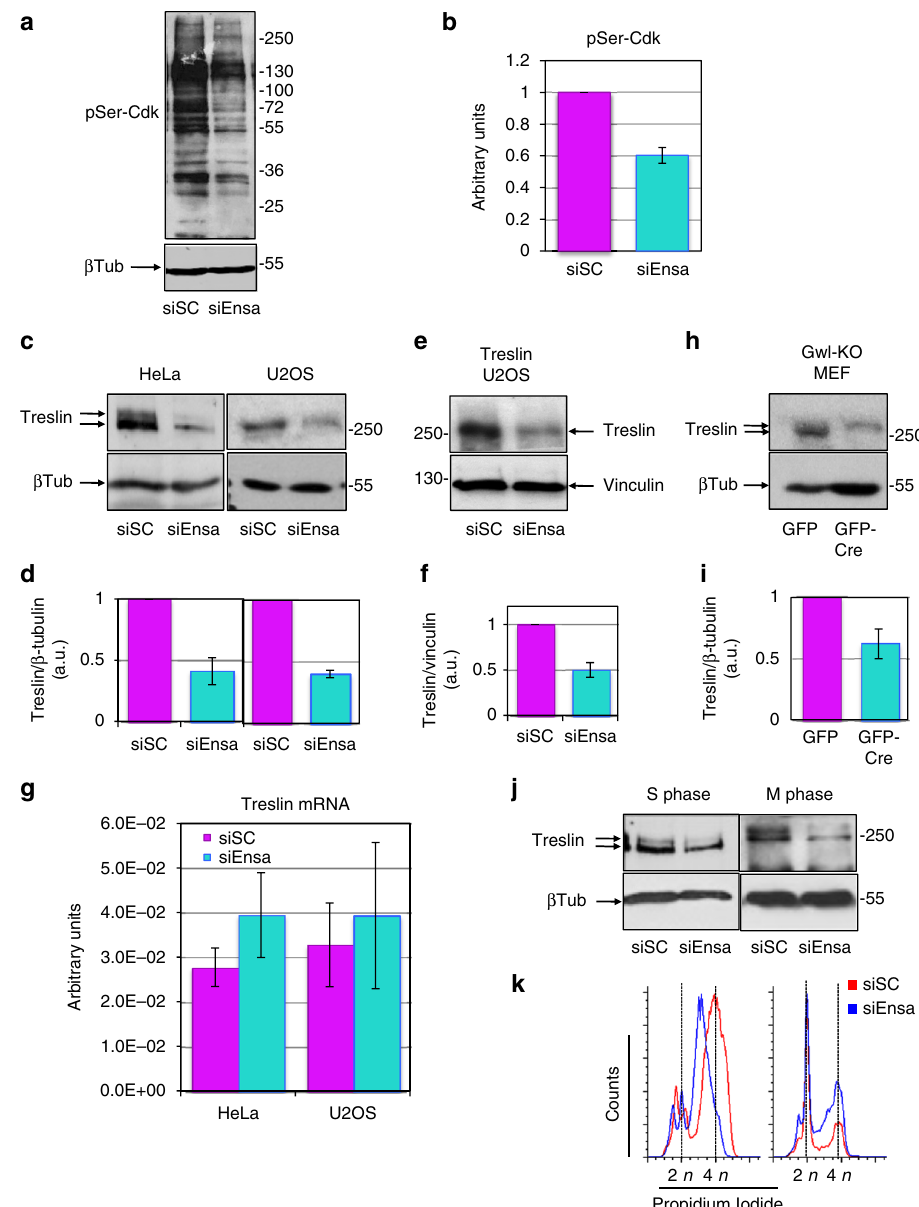
Fig. 7 Depletion of Ensa decreases Treslin protein levels. a Representatitve immunoblotting of phosphorylated Cdk substrates in control (siSC) and Ensa siRNA-treated cells (siEnsa). b Phospho-Ser Cdk intensities on the western blot were measured by densitometry using ImageJ software in fi ve independent experiments. Mean intensity was normalised to controls and represented as bars and standard deviation . c Immunoblotting of Treslin and, as loading controls, β -tubulin in HeLa and U2OS cells treated with scramble (siSC) or Ensa siRNA. d Mean Treslin/ β -tubulin ratios were normalised to controls and represented as a bar graph ± standard deviation. e U2OS cells overexpressing Treslin were treated with scramble (siSC) or Ensa siRNA and used for western blot. f Mean Treslin/Vinculin ratios were normalised to controls and represented as a bar graph ± standard deviation. g Treslin mRNA levels were measured using real-time quantitative PCR in HeLa and U2OS treated with siSC or siEnsa1. Normalisation was made with the expression of the housekeeping gene hsMRPL19 . Data are means ± standard error of mean. h Gwl Lox/Lox MEFs were transduced with GFP or GFP-Cre